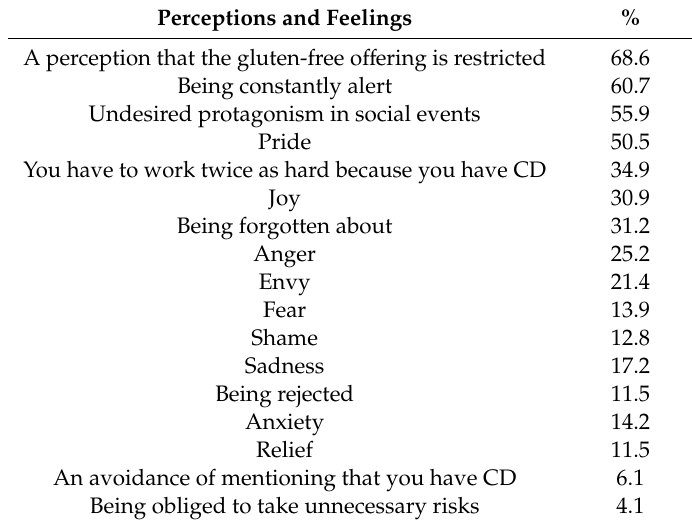
Table 8. Perceptions and emotions associated with having celiac disease (CD), according to